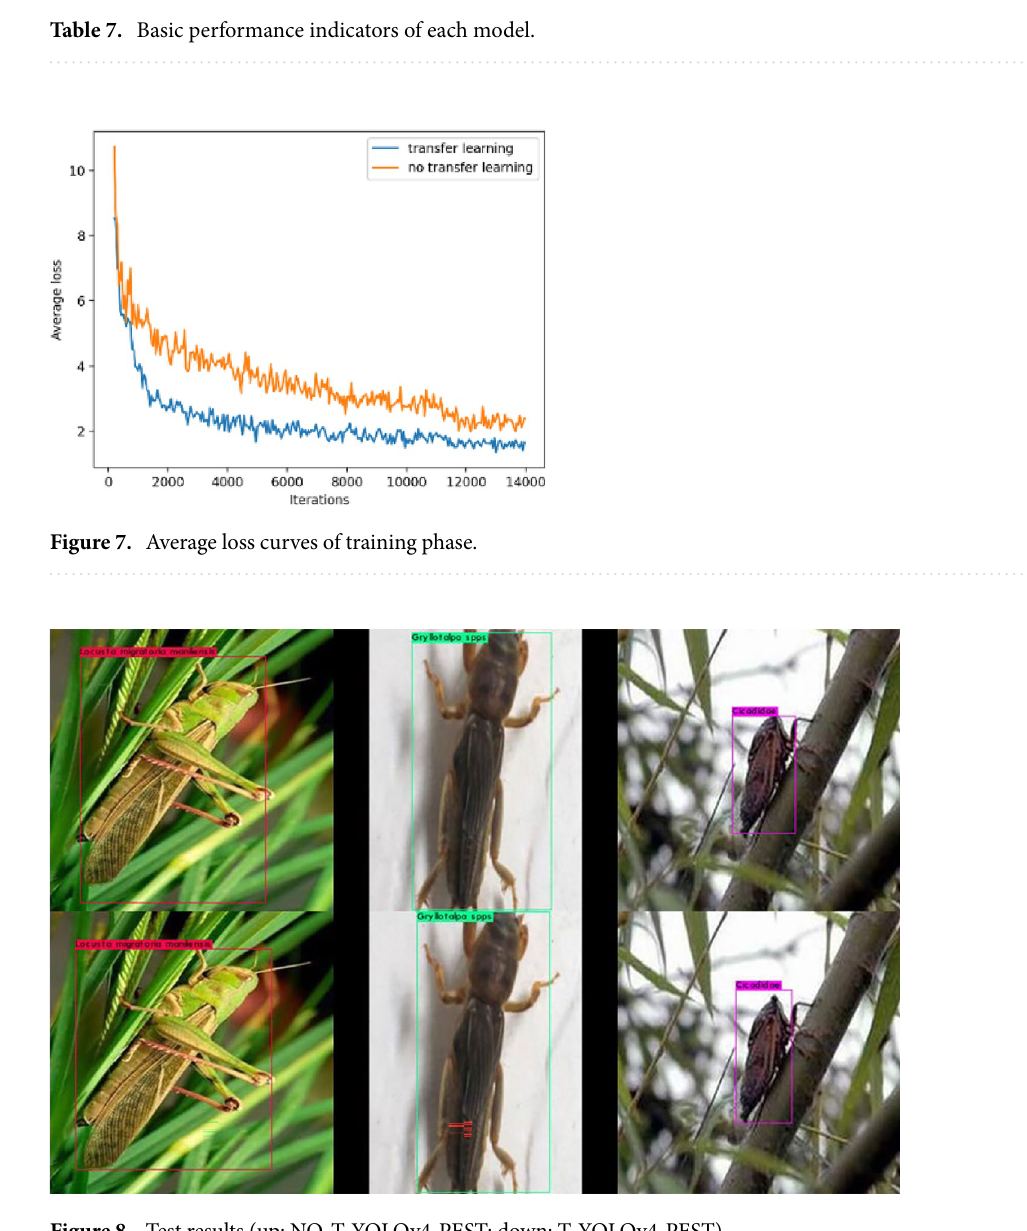
Figure 8. Test results (up: NO-T-YOLOv4-PEST; down: